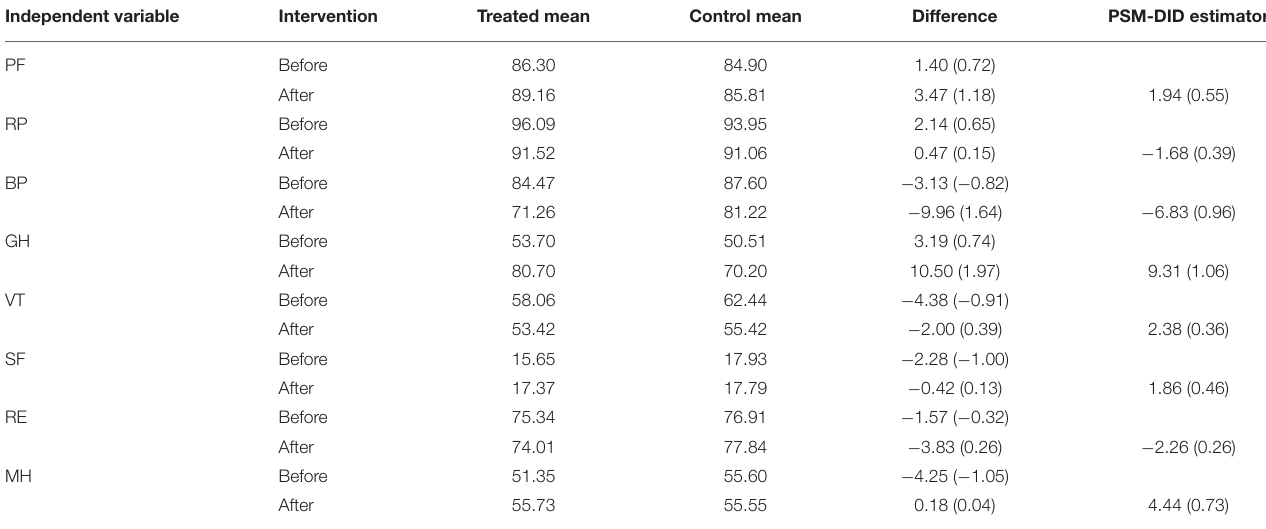
TABLE 4 | Robustness test results of PSM-DID model. Independent variable Intervention Treated mean Control mean Difference PSM-DID